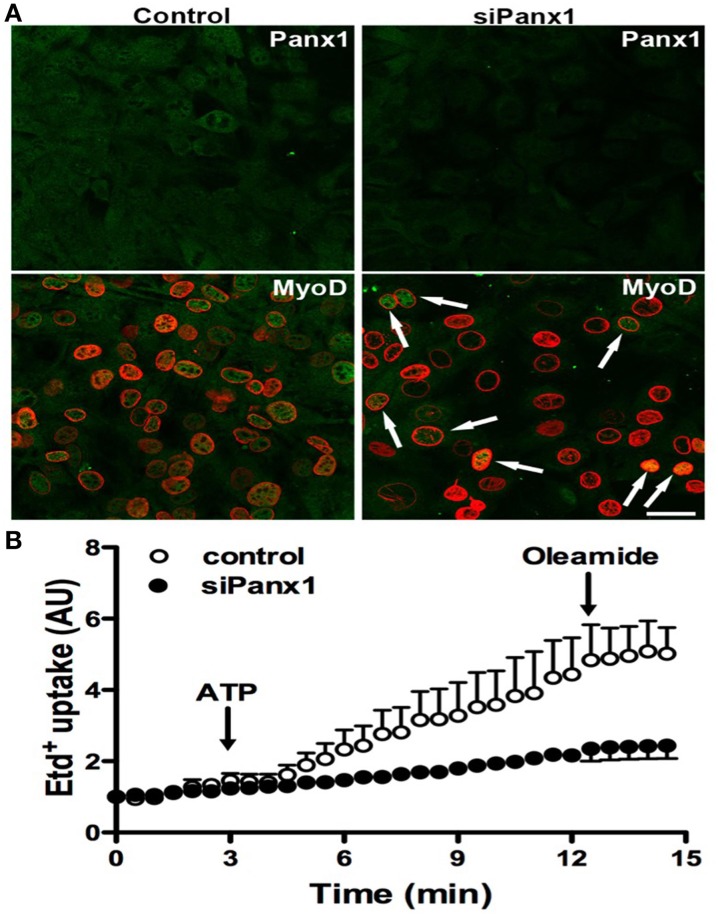
Panx1 is required for ATP-induced myogenic commitment of RCs. Reserve cells (RCs) were isolated from 7 days in differentiated C2C12 cultures and placed on cover slips. For siPanx1 experiments, C2C12 differentiated cultures were transfected with siPanx1 in lipofectamine solution at 24 h before isolation of RCs. After 24 h of isolation of RCs (48 h of siPanx1 transfection) Panx1 reactivity (Green, top panels) was reduced (Top right) as compared to control condition (top left). The MyoD nuclear distribution was analyzed (A, green) by co-immunofluorescence with LAP2 (red signal), which is a nuclear membrane marker. In parallel experiments, hemichannel activity was monitored in ethidium (Etd+) uptake assays (B), where Etd+ uptake was induced with ATP (150 μM) and inhibited with oleamide (100 μM).